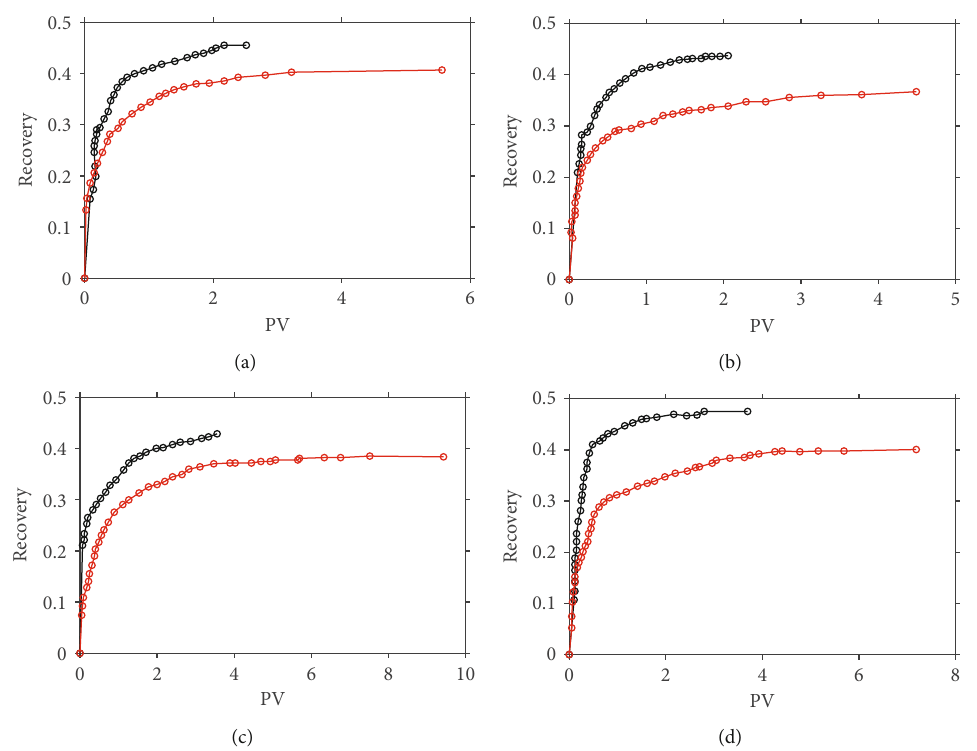
Figure 7: Oil recovery with respect to the injection volume before and after the construction of fracture in the experimental core. The red and black points represent the results before and after the construction of fracture. (a) Cores H1-5. (b) Cores H11. (c) Cores H13. (d) Cores